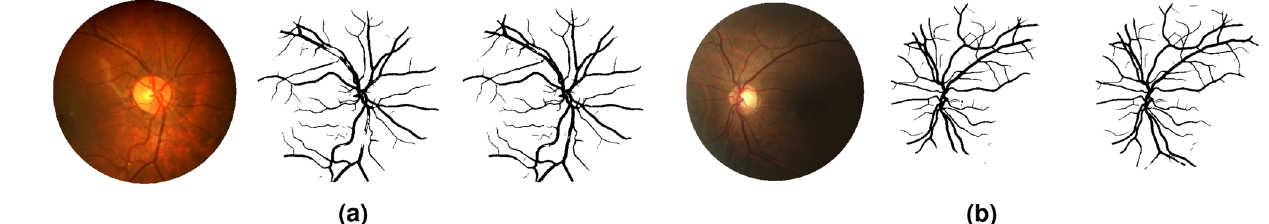
Figure 4. The proposed Domain Adaptation strategy recovers some missing vessels. Segmentations produced by a model trained on DRIVE (which contains macula-centered images) when using data from CHASE-DB and LES-AV (which contain OD-centered images). In ( a , b ), the retinal image (left), the segmentation by the model trained on DRIVE (center) and the one produced by the model trained on pseudo-labels